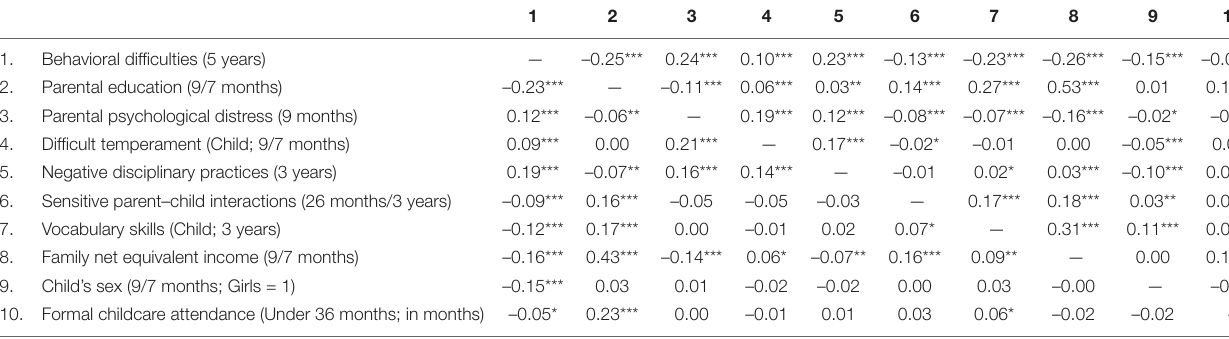
TABLE 2 | Bivariate correlations between study variables: MCS (above diagonal) and NEPS (below diagonal).